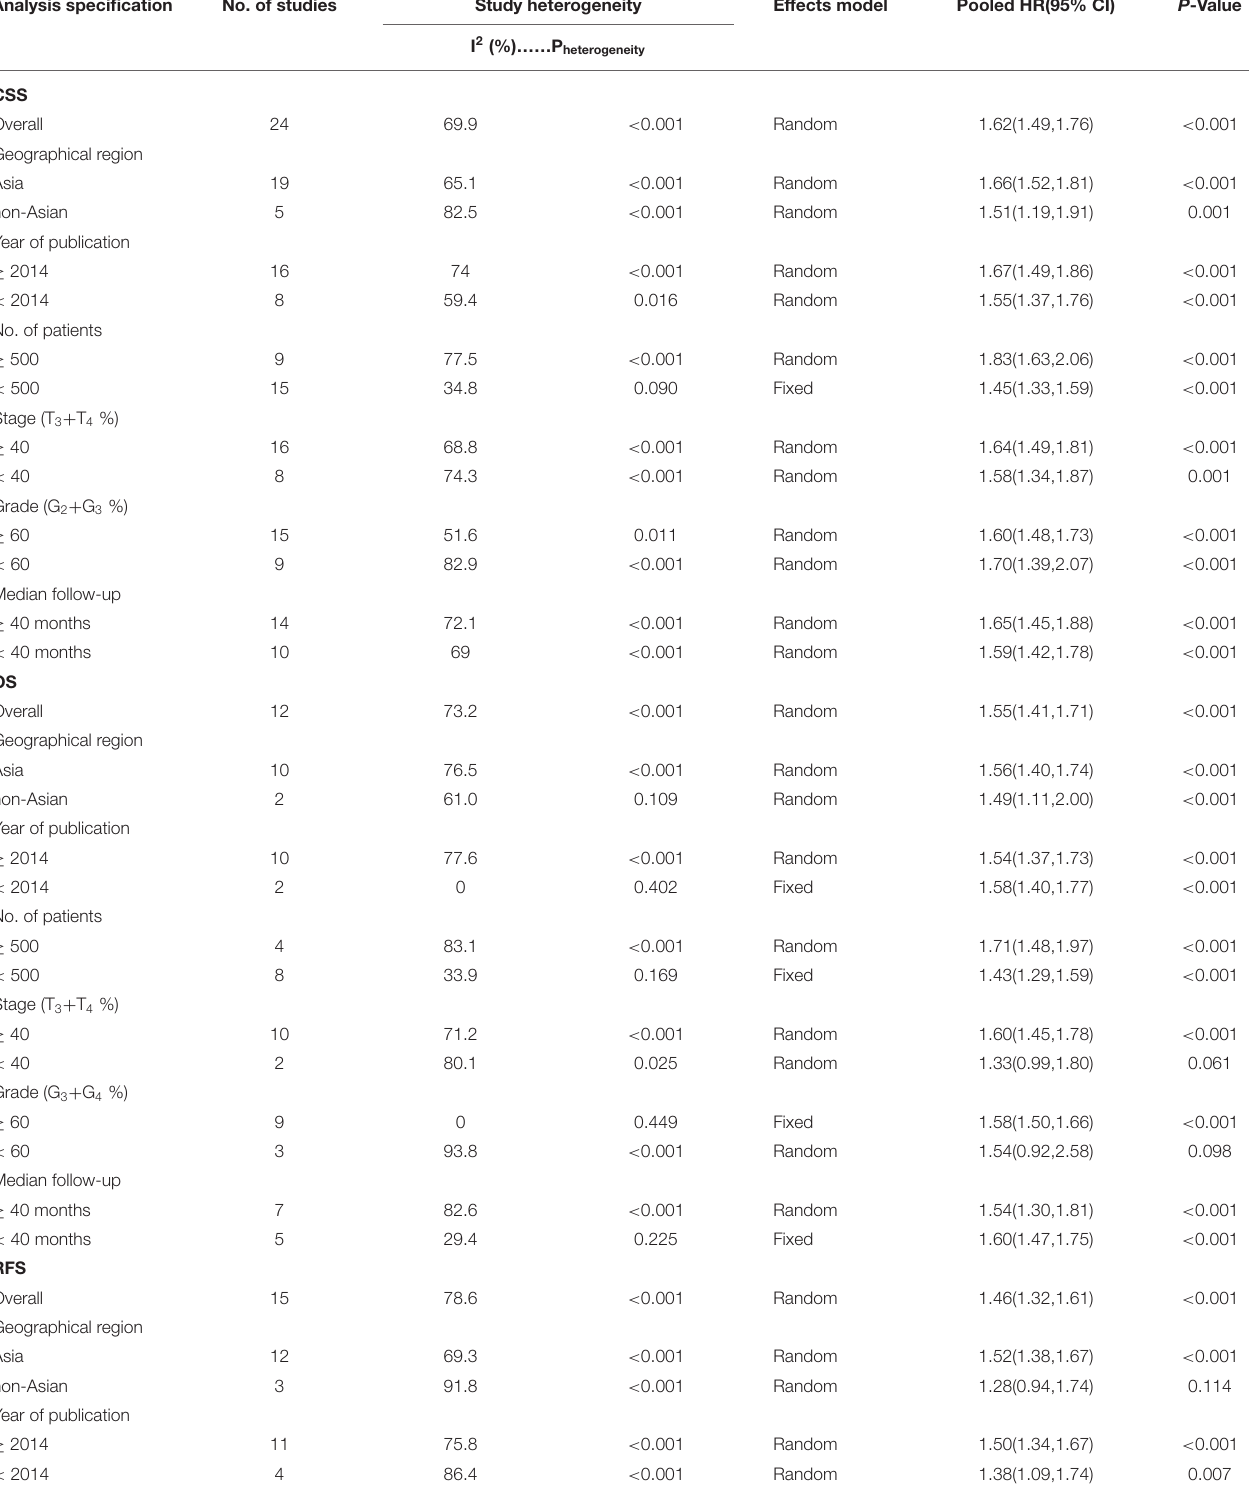
TABLE 3 | Summary and subgroup analysis of pooled ORs for the eligible studies. Analysis